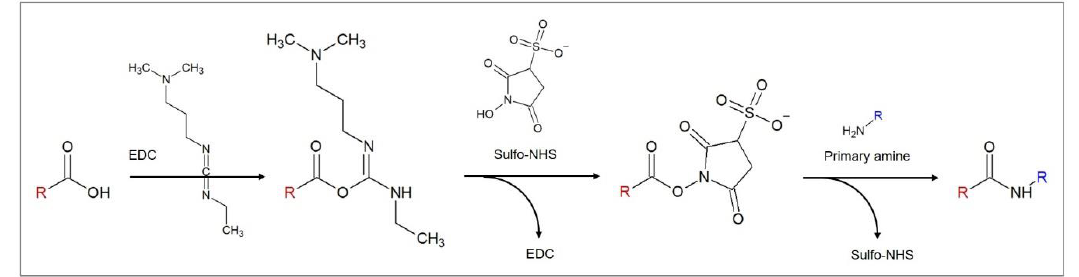
Figure 4. Reaction scheme for the EDC/NHS-assisted amide bond formation between carboxylic acids and primary amines, figure based on [38].